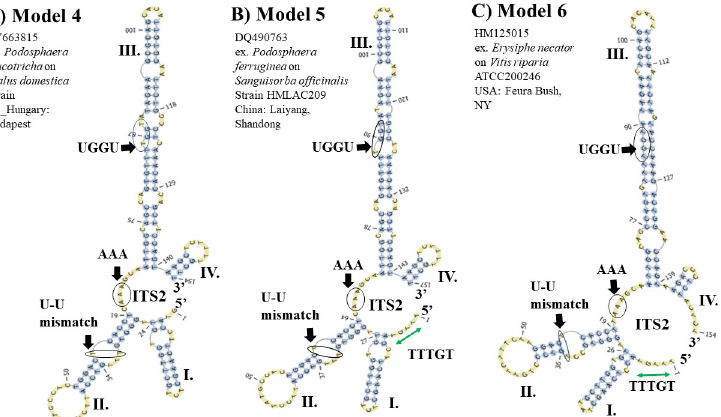
Fig 7. Predicted ITS2 S2 found in the Ampelomyces population isolated from two PM genera, Podosphaera and Erysiphe . (A) The ITS2 S2 Model 4 predicted from Ampelomyces spp. strains extracted from P . leucotricha on Malus domestica . (B) The ITS2 S2 Model 5 from P . ferruginea on Sanguisorba officinalis . (C) The ITS2 S2 Model 6 from E . necator infecting Vitis sp.. M . domestica and S . officinalis are plants from the family Rosaceae, whereas Vitis sp. is a plant from the family Vitaceae. The U-U mismatch motifs, a single-stranded ring rich in adenine nucleotides between helices II and III and a large helix III with a UGGU motif are indicated with black arrows and circles. The structures were directly folded and modelled with the ITS2-DB. The helices are indicated with Roman numerals (I–IV). The single-stranded ring between helices I and IV is indicated with green left right arrows. However, the one from Model 4 is not complete and the green arrow is not shown.